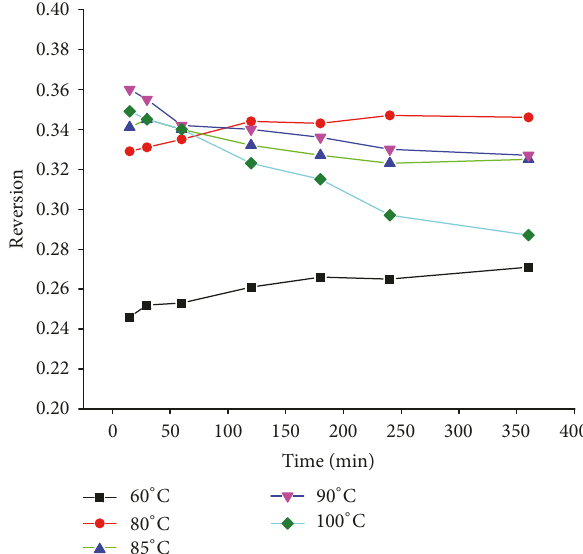
Figure 6: Reversion changes during thermal